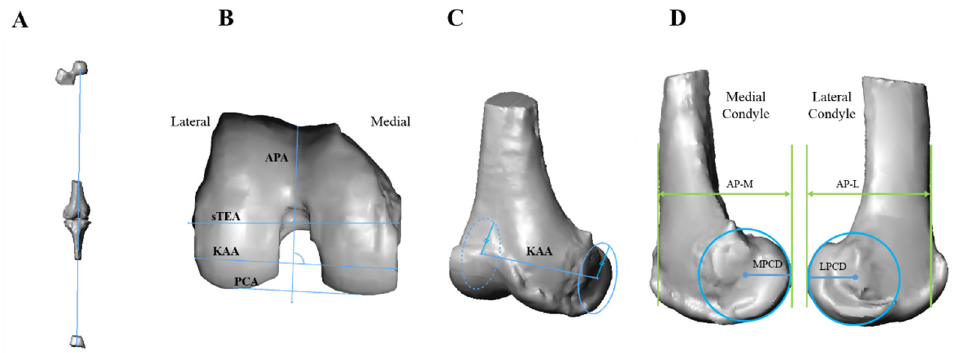
Figure 1. Definition of measurements. ( A ) Hip ֪– knee – ankle angle was defined as the medial angle between mechanical axes of femur and tibia. ( B ) Rotational references of axial plane in mechanically aligned total knee arthroplasty (TKA), anteroposterior axis (APA), surgical transepicondylar axis (sTEA), posterior condylar axis (PCA), and kinematically aligned axis (KAA). ( C ) Definition of KAA. The best-fit circle to non-affected posterior femoral condyle was propagated to the affected condyle and was located to best fit. The diameters of the two circles in this composite are the same. ( D ) Medial posterior condylar diameter (MPCD) and lateral posterior condylar diameter (LPCD) were defined as the radii of the circles, best fit to each posterior femoral condyle. MPCD and LPCD are not the same.